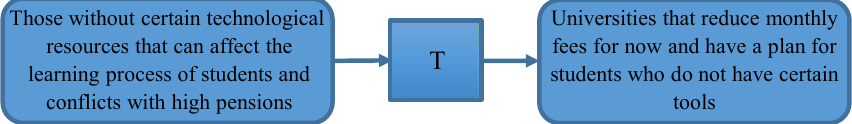
Fig. 8. Supporting parents with technology tools for virtual classroom